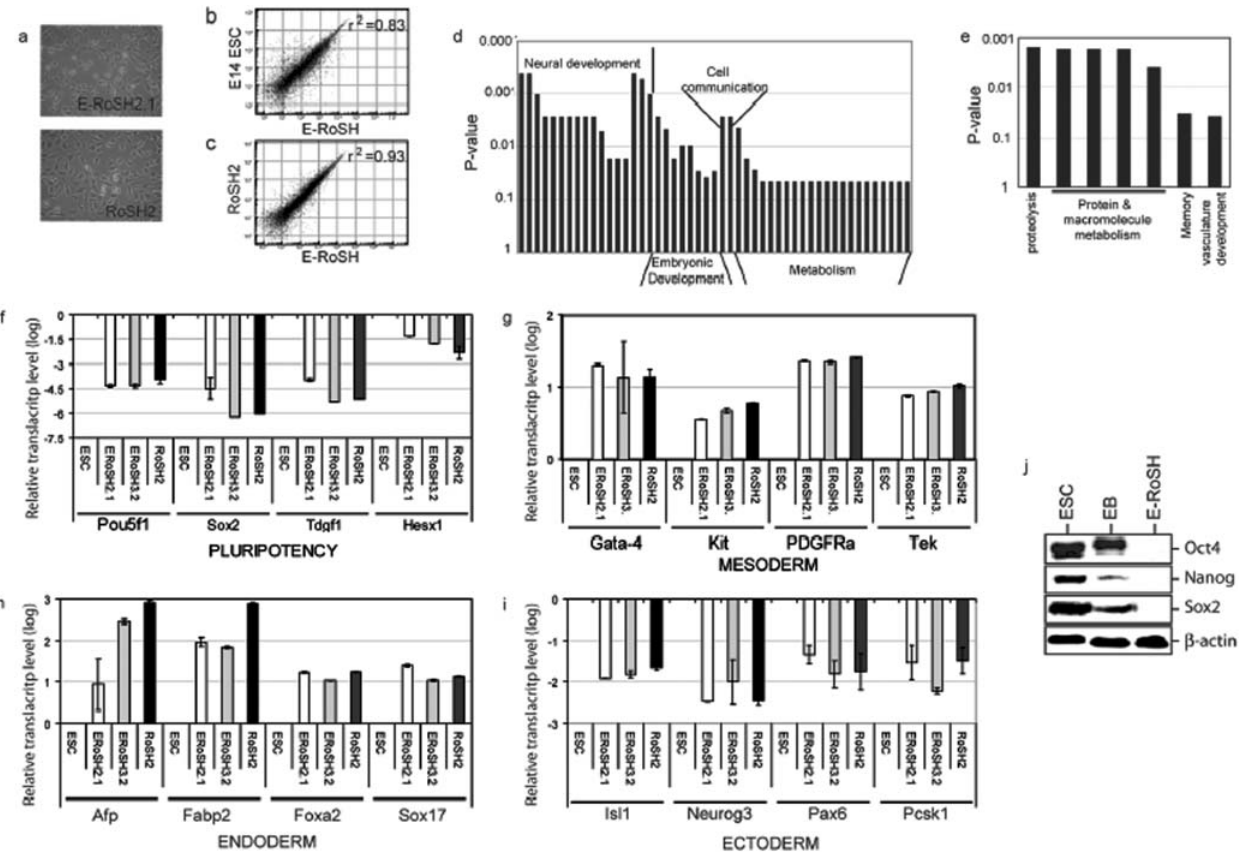
Figure 2 . Characterisation of E-RoSH cell lines. a) Cellular morphology of E-RoSH2.1 and RoSH2 cells in sub-confluent cultures; b,c) Pairwise comparison of global gene expression between E14 ESCs and E-RoSH2.1/E-RoSH3.2, and RoSH2 and E-RoSH2.1/E-RoSH3.2. Global gene expression analysis of E14 ESCs, E-RoSH, RoSH were performed by hybridizing total RNA from two biological samples each of E14 ESCs, E-RoSH2.1, E-RoSH3.2, and RoSH2 with Illumina BeadArray containing about 24,000 unique features; d) Biological processes in which 1115 highly expressed genes in ESCs have statistically significant higher frequencies (p , 0.05). The biological processes were ( left to right ): neuron differentiation, neuron development, nervous system development, neuron maturation, nerve ensheathment, cellular nerve ensheathment, ionic insulation of neurons by glial cells, myelination, transmission of nerve impulse regulation of action potential, neurophysiological process, neuron morphogenesis during differentiation, neurite morphogenesis, axonogenesis, cell development, development, system development, cell maturation, cell differentiation, cellular morphogenesis, regulation of gene expression, epigenetic Imprinting, gametogenesis, morphogenesis, sexual reproduction, cell-cell signalling, cell communication, metabolism, cell organization and biogenesis, regulation of biological process, macromolecule catabolism, carbohydrate catabolism, cellular carbohydrate catabolism, monosaccharide catabolism, hexose catabolism, glucose catabolism, glycolysis, cellular macromolecule catabolism, cellular catabolism, alcohol catabolism, carbohydrate metabolism, cellular carbohydrate metabolism, monosaccharide metabolism, hexose metabolism, glucose metabolism, main pathways of carbohydrate metabolism alcohol metabolism, generation of precursor metabolites and energy, energy derivation by oxidation of organic compounds; e) Biological processes in which 1263 highly expressed genes in ESCs have statistically significant higher frequencies (p , 0.05). The biological processes were ( left to right ): proteolysis, protein metabolism, cellular protein metabolism, cellular macromolecule metabolism, macromolecule metabolism, memory and vasculature development; f,g, h, i) Relative gene expression analysis by quantitative RT-PCR analysis. The expression level was normalized against that of ESCs and expressed as a logarithmic function; j) Western blot analysis for pluripotency-associated gene products in cell extracts of ESCs, EBs and E-RoSH2.1